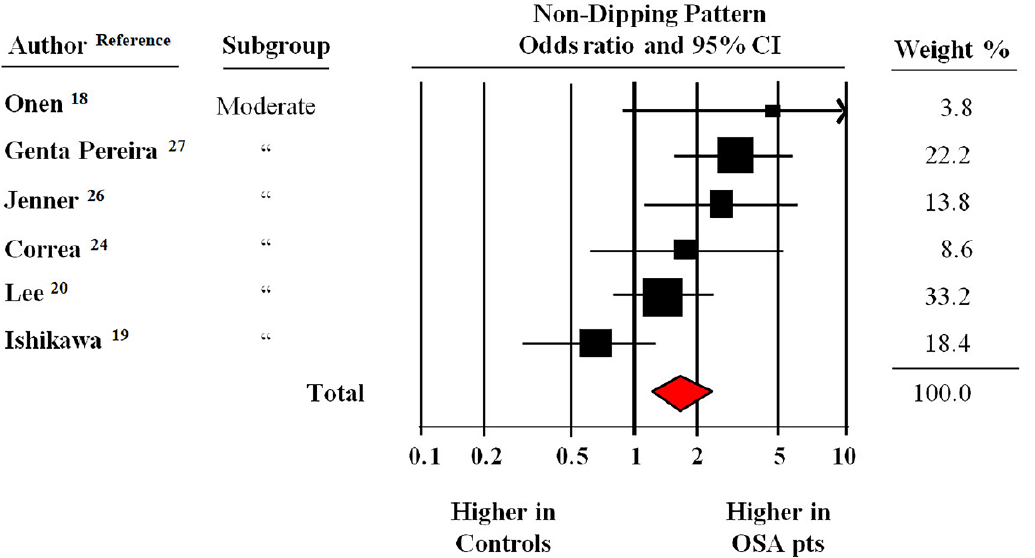
Figure 4. Odds ratio of non-dipping pattern during 24-hour blood pressure monitoring in patients with obstructive sleep apnea (OSA) of moderate to a severe degree compared to controls [18–20,24,26,27]. Data from six studies and 1198 participants with and without OSA. Fixed model ( I 2 = 59).